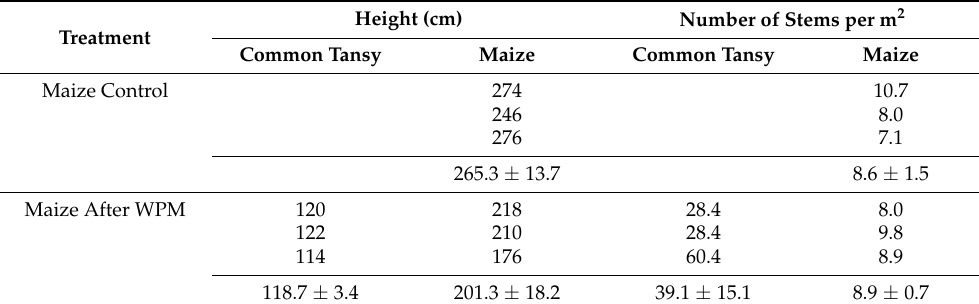
Table 1. An overview of the morphological parameters of maize, common tansy and the total biomass per treatment. For each observation, the raw data, average values and standard deviations are shown.